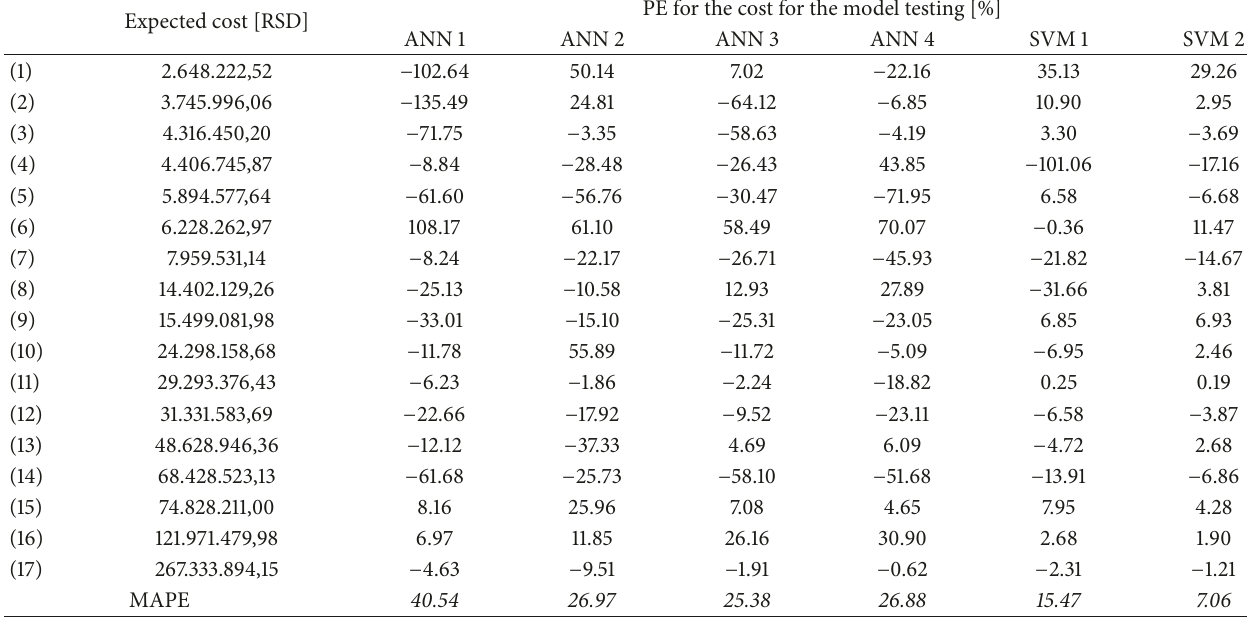
Table 11: PE for estimation of costs, testing set.